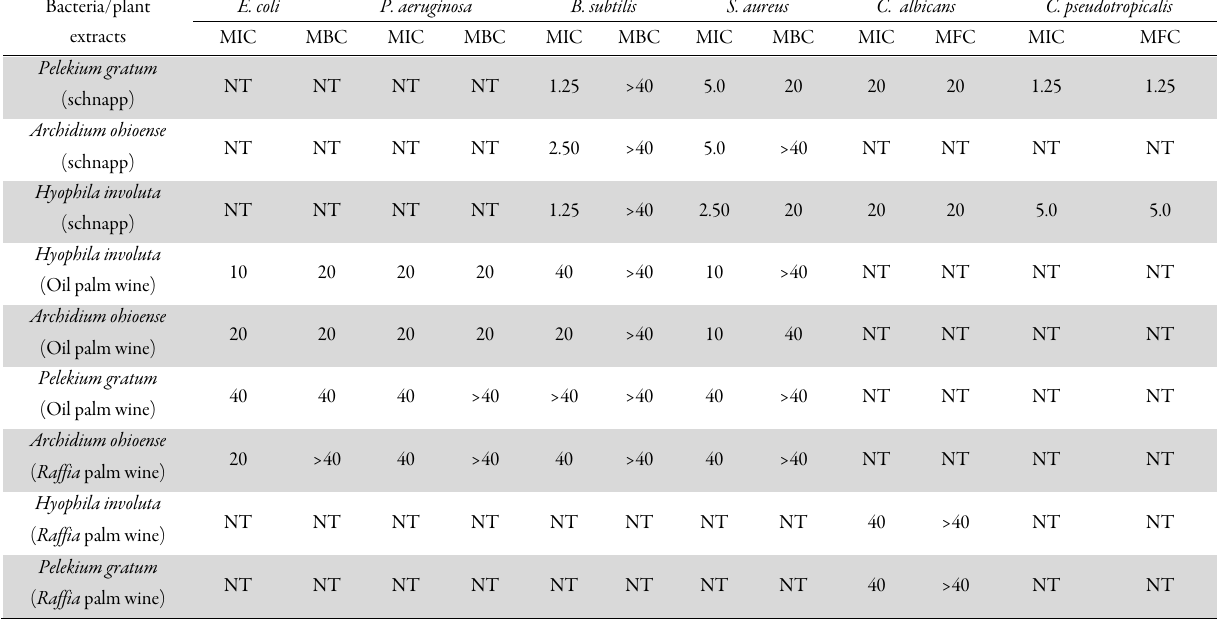
Table 6. The minimum inhibitory concentration (MIC) mg/ml, minimum bactericidal concentration (MBC) mg/ml and minimum